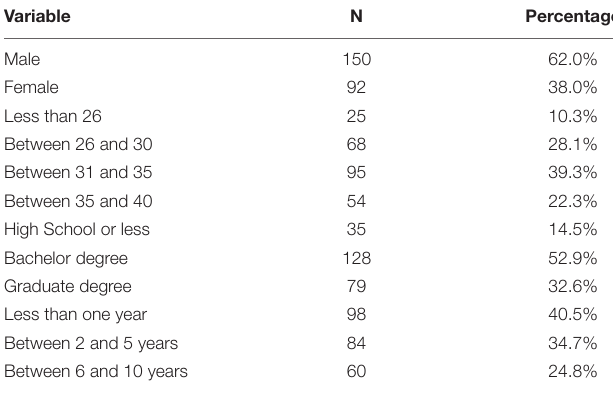
TABLE 1 | Demographics of the survey